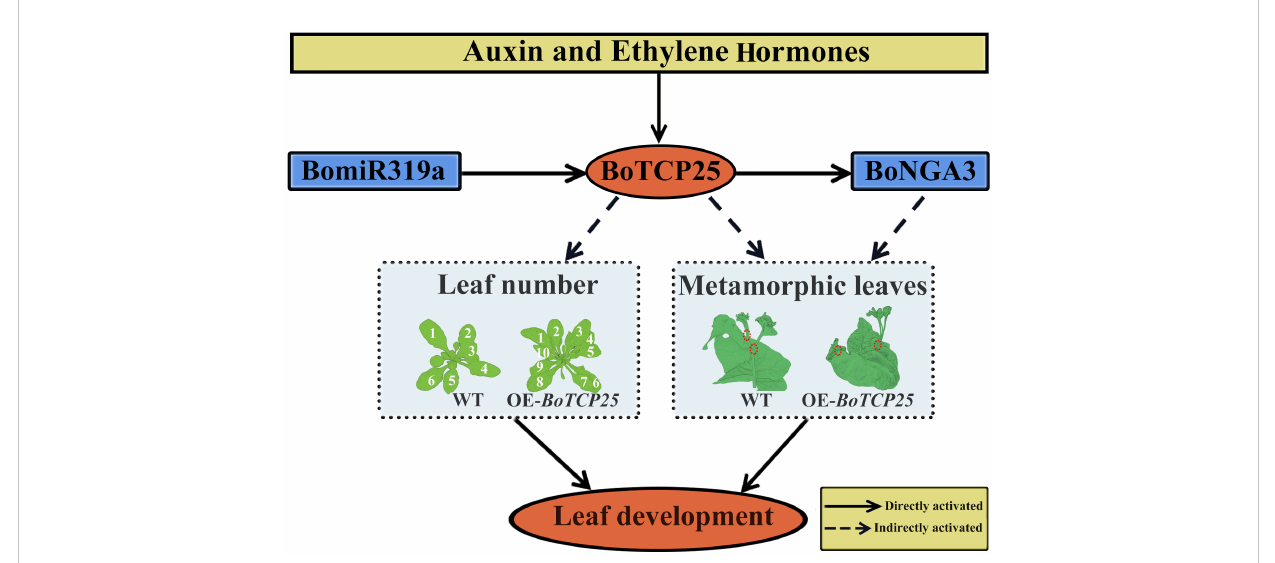
FIGURE 8 Diagram of potential regulatory mechanisms of BoTCP25 and its role in leaf development. The function of BoTCP25 in leaf development differs in Arabidopsis and Chinese kale. In Arabidopsis (left-box), BoTCP25 is related to the leaf number and leaf area, while in Chinese kale (right-box), BoTCP25 participates in changing the localization of metamorphic leaves. The expression of BoTCP25 was regulated by miR319 and responded to the plant hormone auxin and ethylene. Besides, BoTCP25 can also bind to the promoter of BoNGA3 to regulate the expression of BoNGA3 . The module miR319-BoTCP25-BoNGA3 may function together in the regulation of leaf development. The number means leaf numbers in different plants. The red circle means the position of metamorphic leaves. The straight arrows are for direct action and the dashed arrows are for indirect